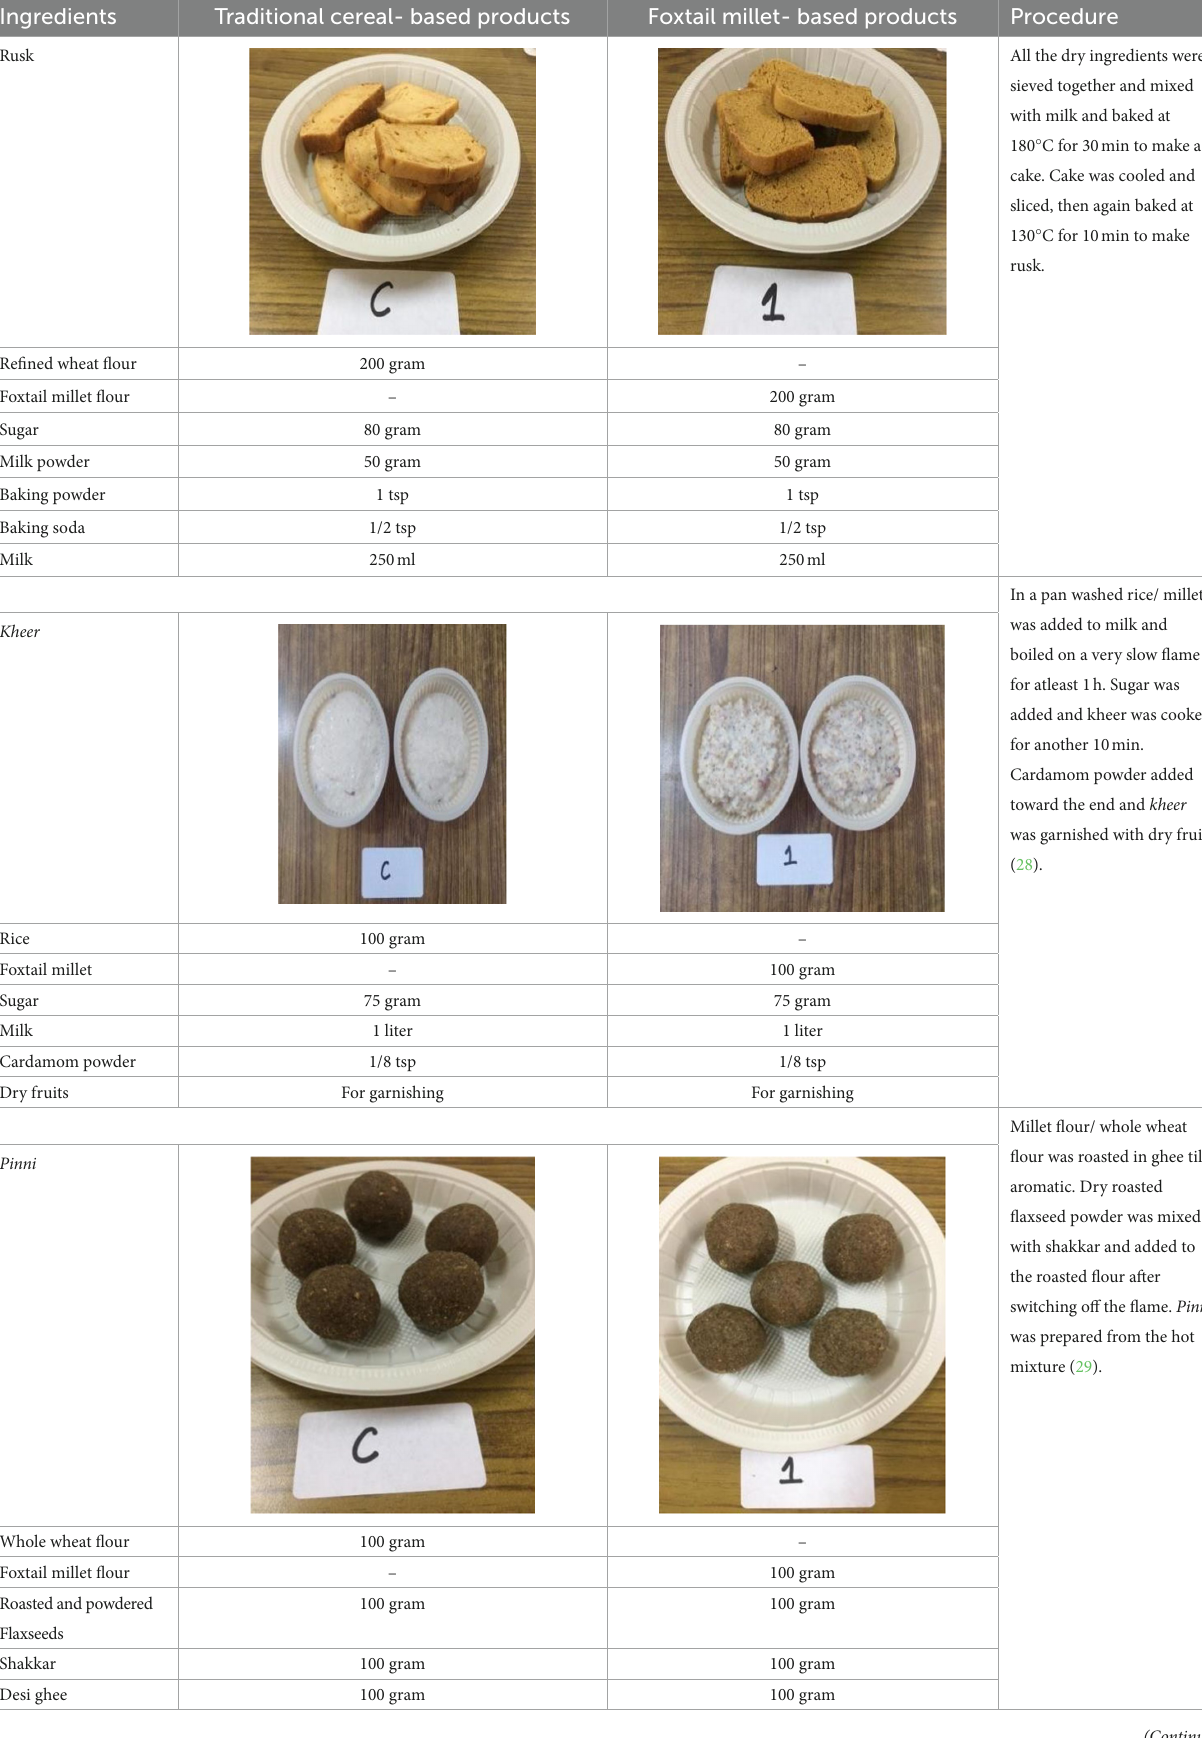
TABLE 1 Value- added products developed using foxtail